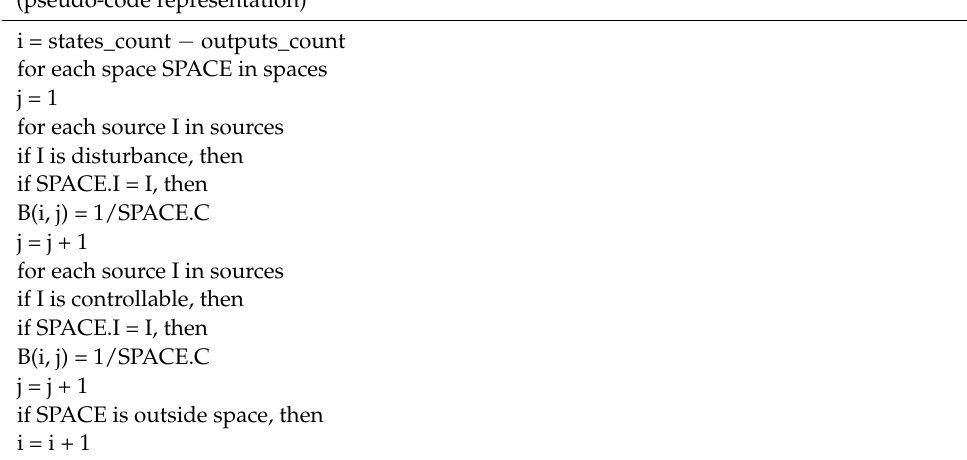
Algorithm 6. The modification of the input matrix B —spaces and sources (pseudo-code representation)